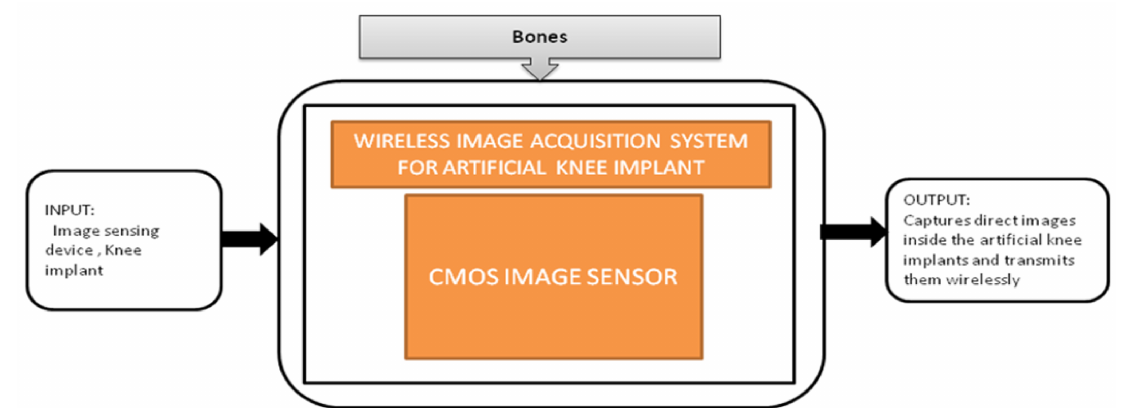
Figure 38. Wireless image acquisition system for knee replacement implant in total knee